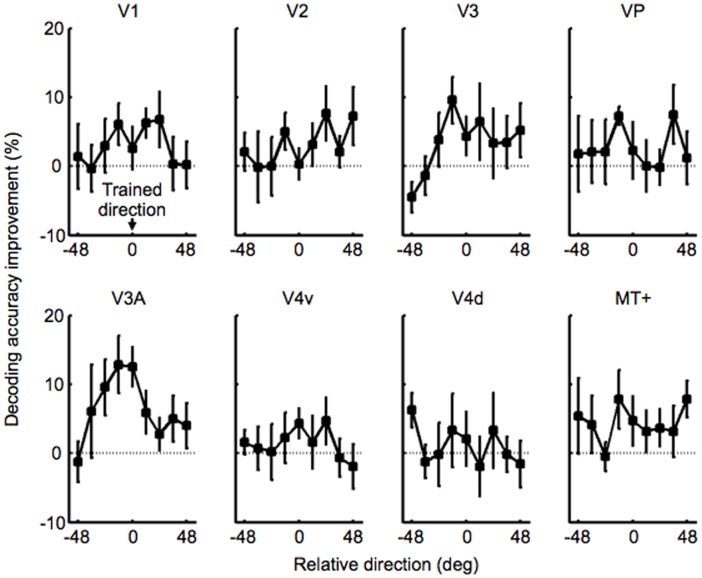
A decoded tuning improvement function for each ROI.Mean decoding performance improvement across the subjects was calculated by subtracting decoding accuracy in the pre-fMRI stage from that in the post-fMRI stage for each of 9 motion directions. Significant improvement for the trained direction was obtained only in V3A (paired t-test, P<0.05, false discovery rate, corrected by the number of the ROIs). Error bars represent SEM.